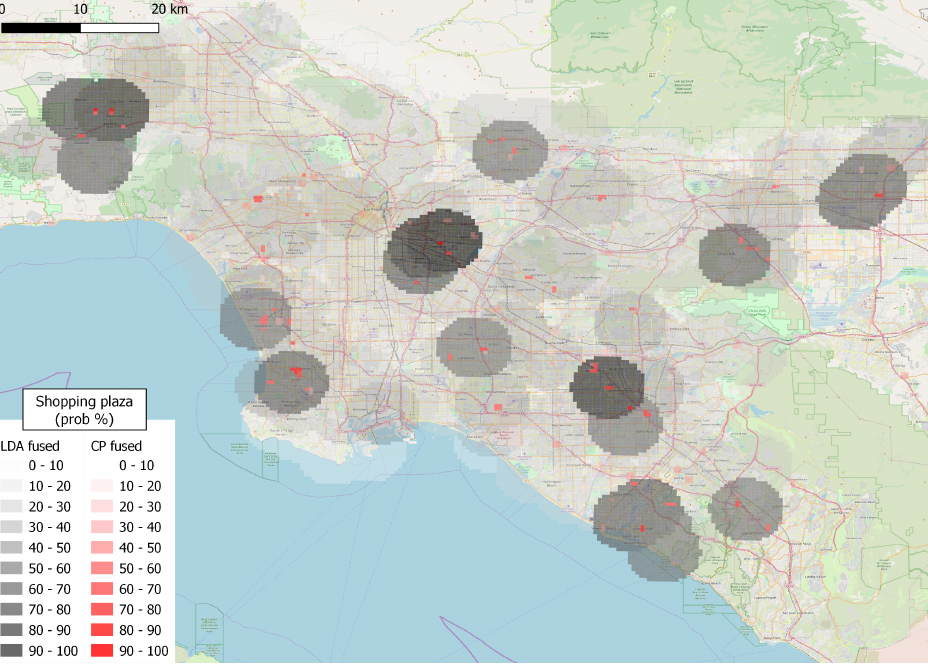
Figure 6. Shopping plazas in Los Angeles - results of each approach adjusted using the